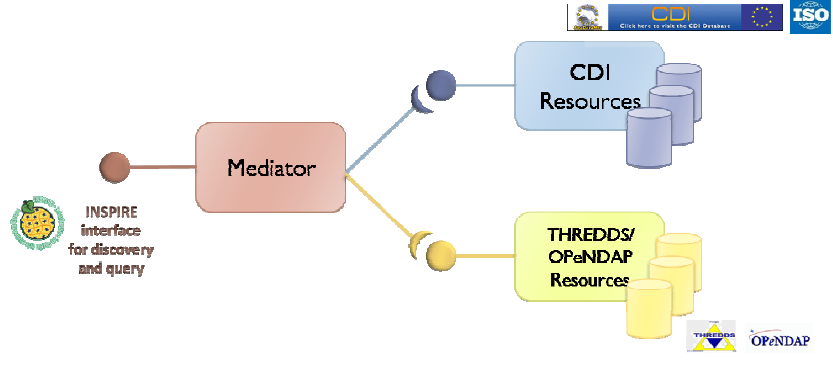
Figure 1: The adopted interoperability solution for CDI and THREDDS/OPENDAP. 2 Fig. 1. The adopted interoperability solution for CDI and THREDDS/OPENDAP. 3